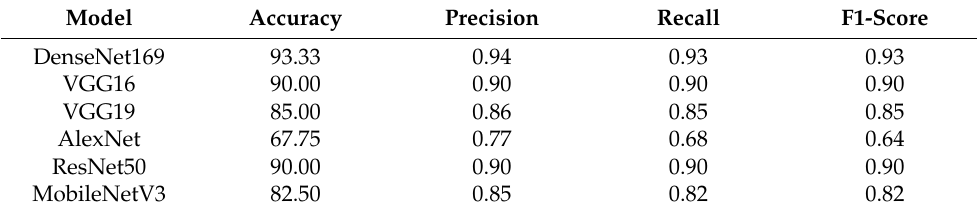
Table 5. Performance results of the deployed pretrained DL models with segmentation.